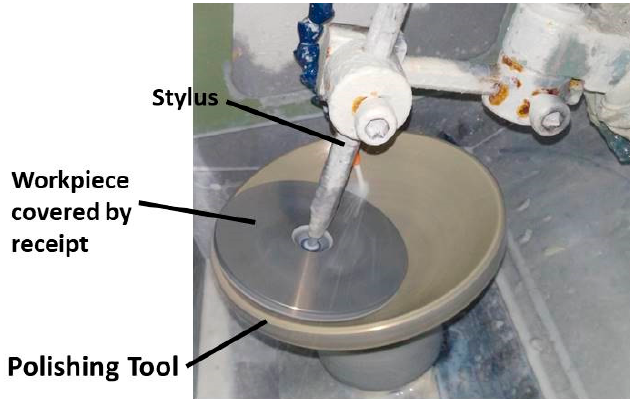
Figure 6. Calculation results of the relative velocity distribution for polishing parameters at α = 9°, ω p = 500 RPM, D = 90 mm, R = 175 mm, f = 10 Hz, θ = 24°.